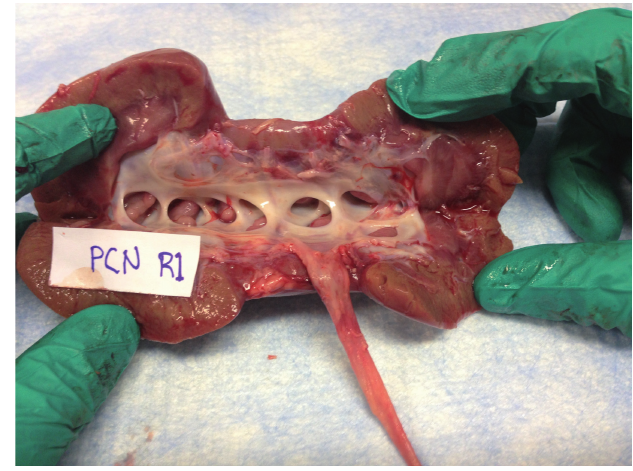
delivery.figure 1 - Representative image after retrograde dye delivery with ureteral